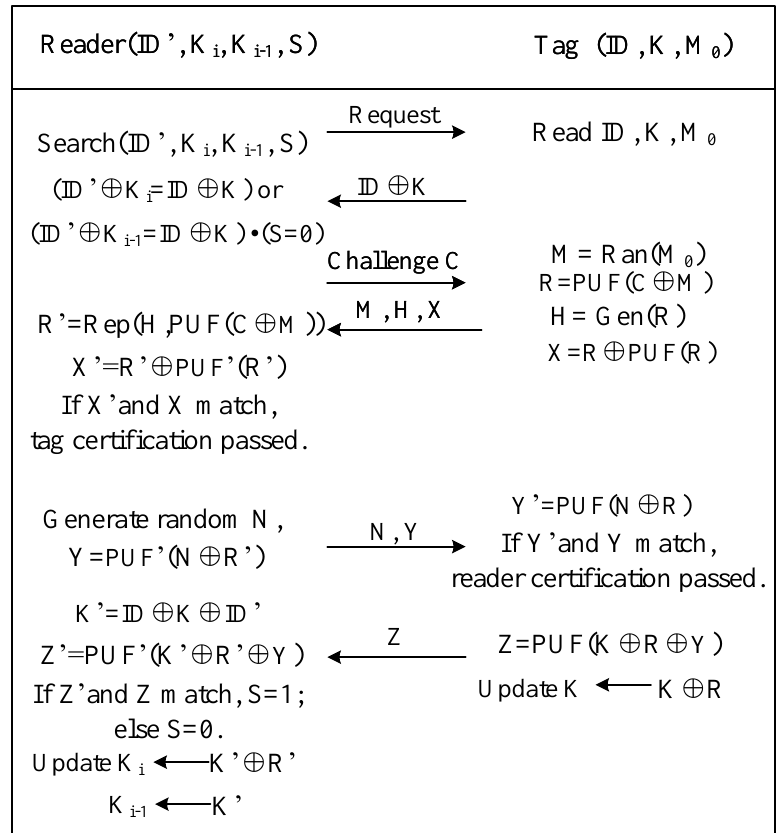
Figure 4. The flow chart of the authentication